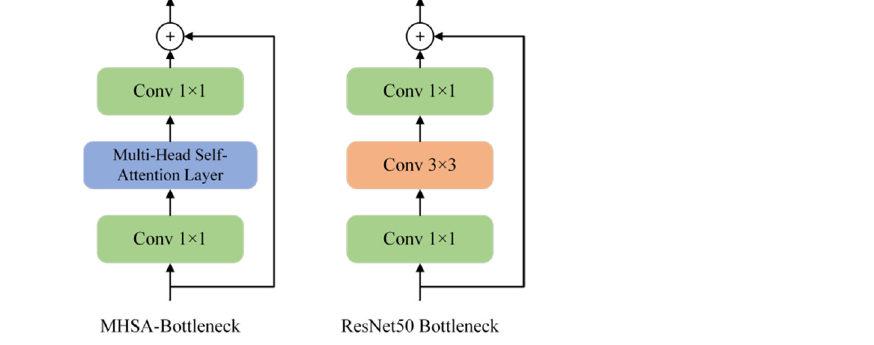
Figure 3. The architecture of MHSA-Bottleneck and comparison with standard ResNet50 bottleneck.